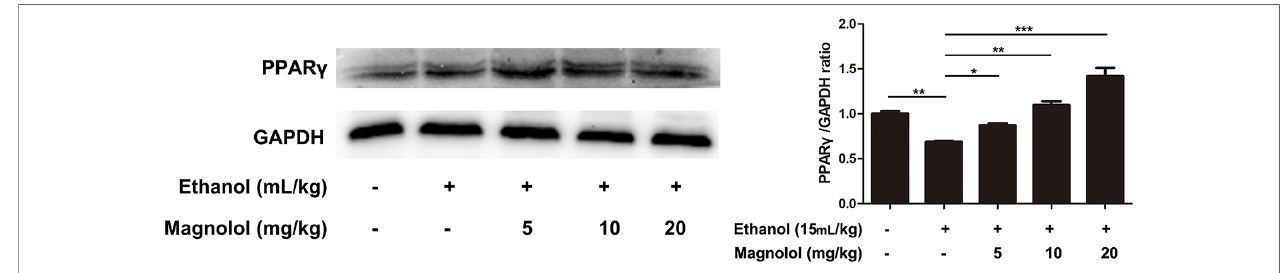
FIGURE 8 | Effects of magnolol on mice alcohol-induced liver damage in PPAR g expression. The collected samples were analyzed for the expression of PPAR g using western blotting analysis. The expression of PPAR g was compared with GAPDH. The data were demonstrated as means ± SD. (*P < 0.05, **P < 0.01, ***P < 0.001 and "ns" means not signi fi cant).